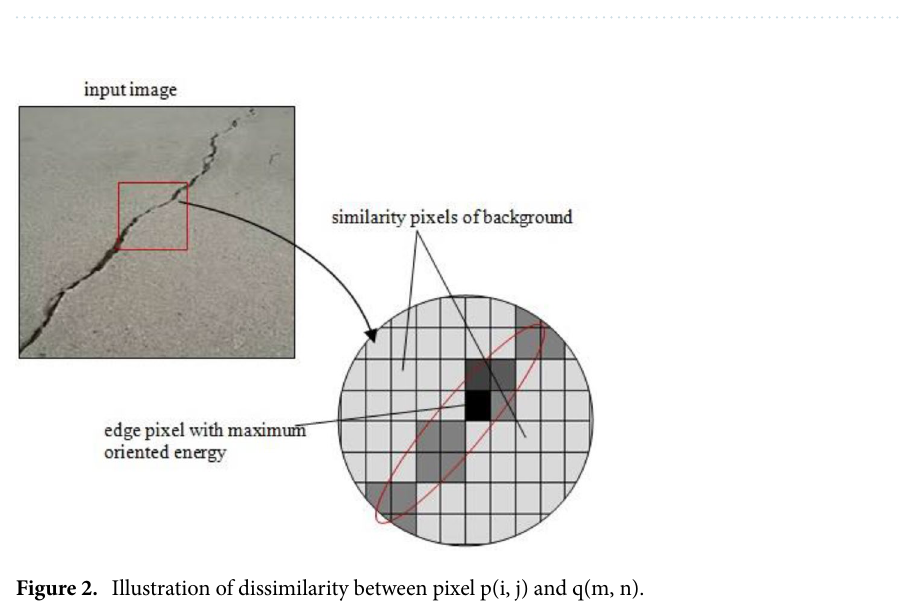
Figure 1. Two-dimensional Gaussian distribution surface curve.